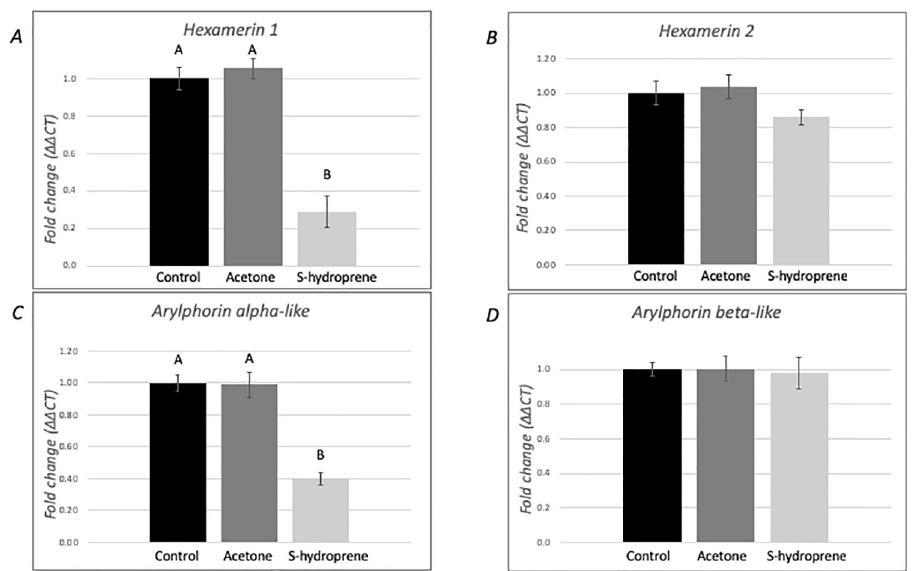
Fig 5. Expression analysis of hexamerin transcripts in alate virgin queens 12 h following topical application of S- hydroprene. Relative expression of (A) hexamerin 1 , (B) hexamerin 2 , (C) arylphorin subunit alpha-like , and (D) arylphorin subunit beta transcripts. Gene expression was quantified using RT-qPCR and analyzed using the ΔΔ Ct method. For each gene, mRNA expression level was normalized relative to rp18 . Bars represents mean ± SEM fold change relative to untreated control ( n = 6). Significant differences in gene expression ( p < 0.05) were determined for hexamerin 1 and arylphorin subunit alpha-like . For those genes, different letters indicate significant differences in gene expression as determined with Tukey post hoc analyses.